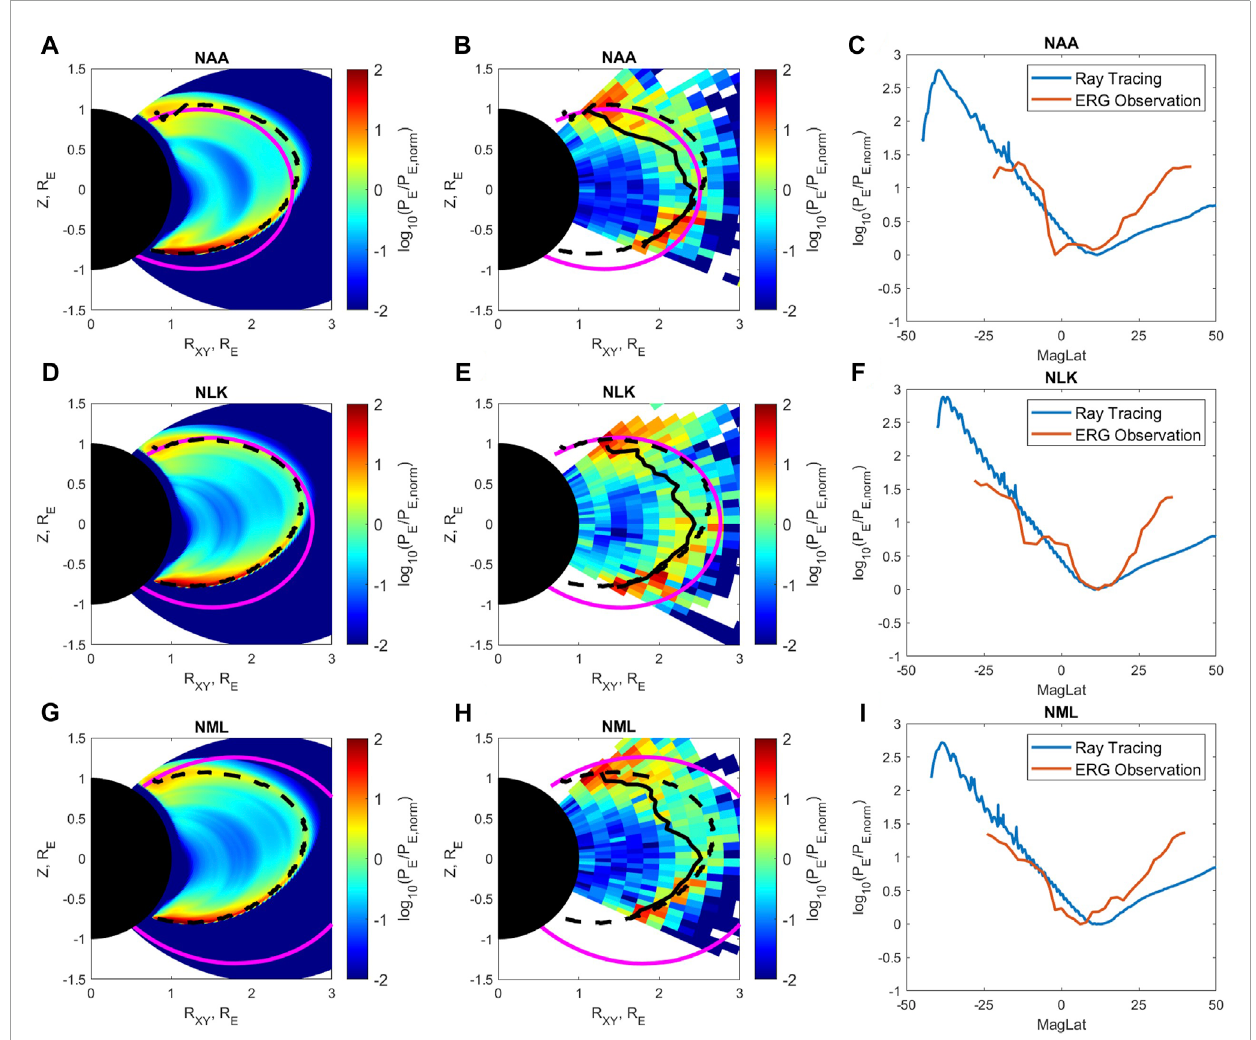
FIGURE 4 Similar analyses results from the Ray Tracing simulation and ERG/Arase observation as Figure 3 for NAA (A–C) , NLK (D–F) , and NML (G–I) transmitters.